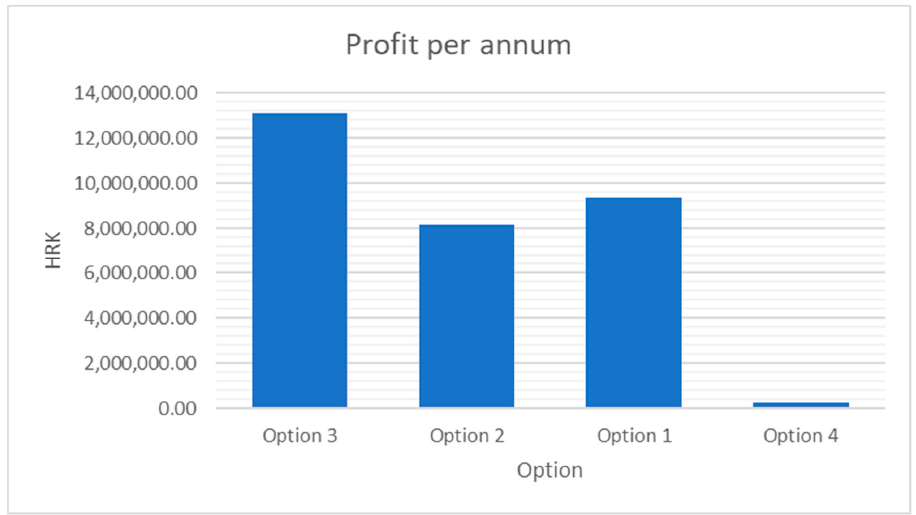
Figure 3. Profit of each facility per annum with incentive prices